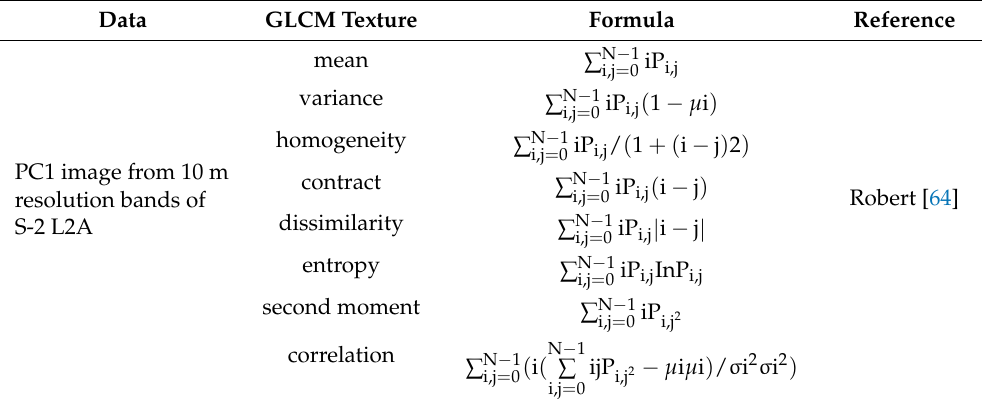
Table 3. Gray level co-occurrence matrix-based textural measures extracted in the current work.